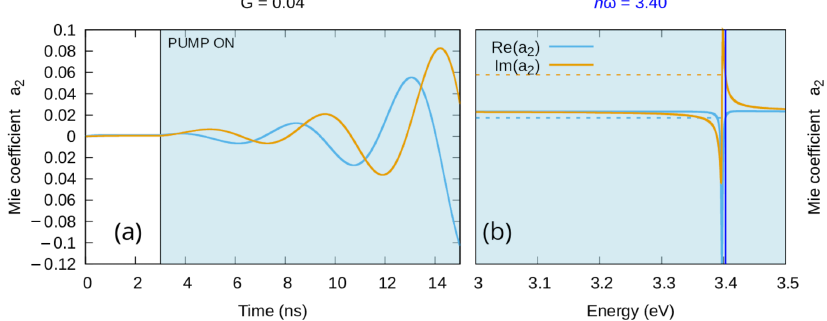
Figure 5. Real and imaginary part quadrupolar coefficient of the Mie expansion of the scattered field for a silver nanoparticle of radius 60 nm in water enriched with a gain medium above the emission threshold G = 0.04 with emission bandwidth ∆ = 0.15 eV. Here, the emission central frequency ¯ h ω 21 = 3.4 eV was chosen to correspond to the resonance frequency of the quadrupolar mode. ( a ): Time dependencies for a single frequency; ( b ): corresponding steady state